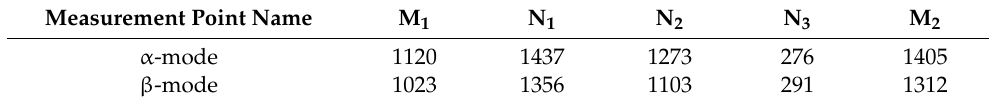
Table 4. Time for the line modulus component to reach each endpoint.